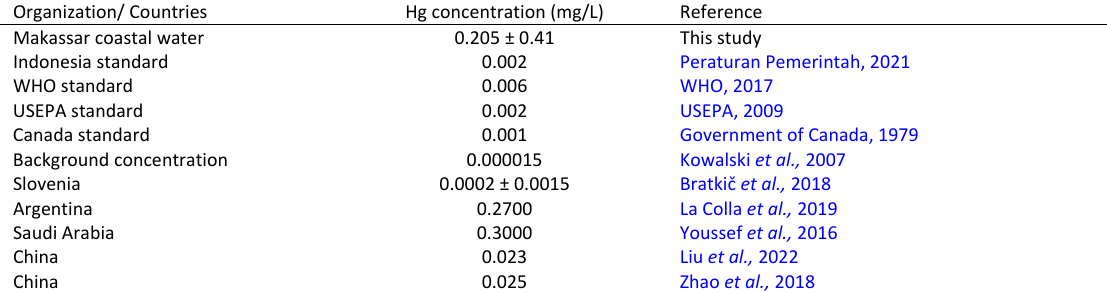
Table 1: Comparison of Hg concentration in the study area with water quality standards and previous results from other countries